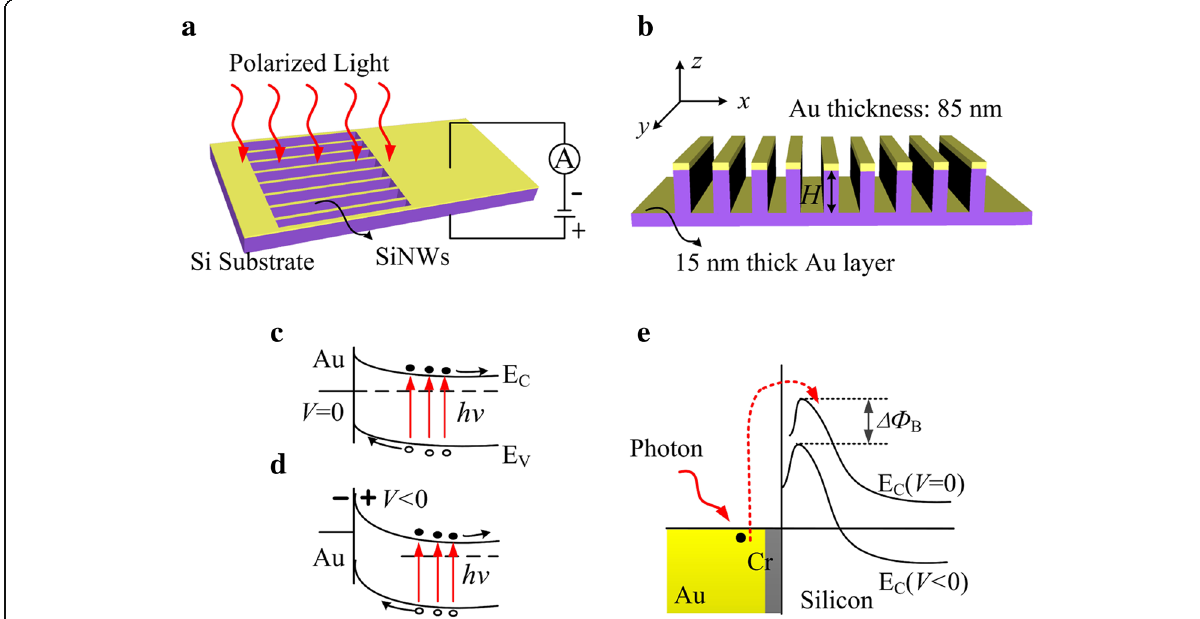
Fig. 1 Schematic diagram of the resonator tuned MS photodetector in silicon and its photo-electronic principle. a , b The diagram of the detector. c , d The energy band for simple MS junction under IR illumination with and without the DC bias. e The diagram showing the internal emission of hot electrons from surface